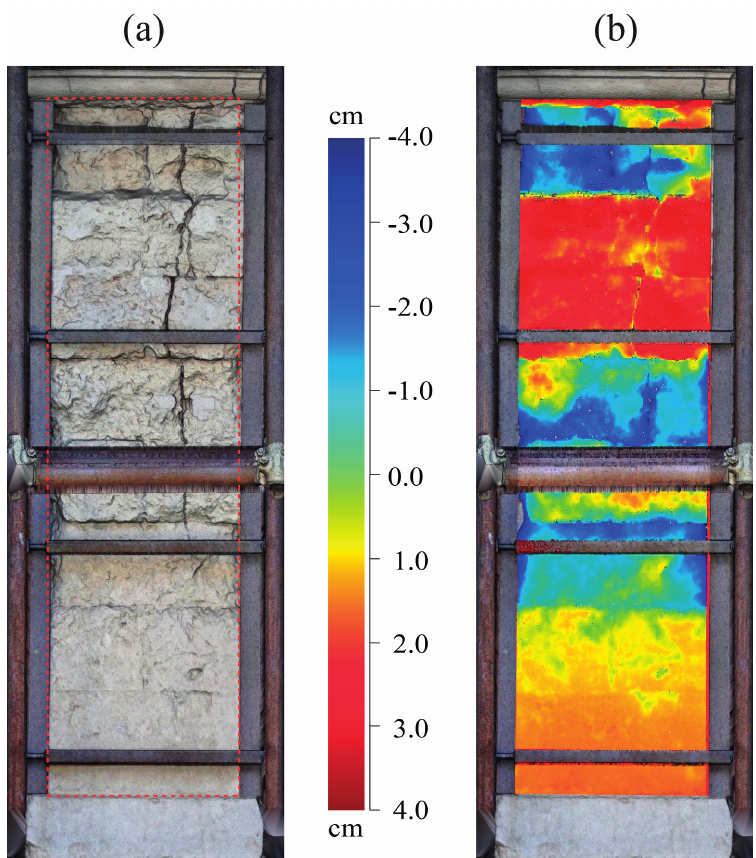
Figure 9. Results of the detailed analysis on a column of the inner colonnade: ( a ) mesh with extremely high resolution; ( b ) map of the residual respect with the best-fitting